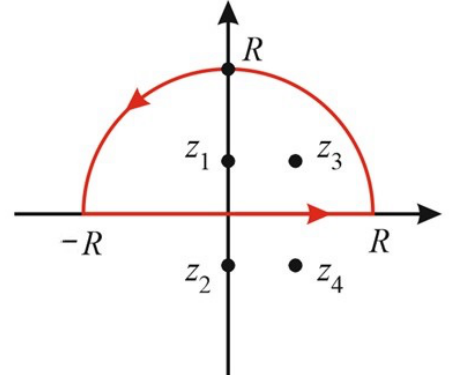
Figure 3. Illustration of taking the integral